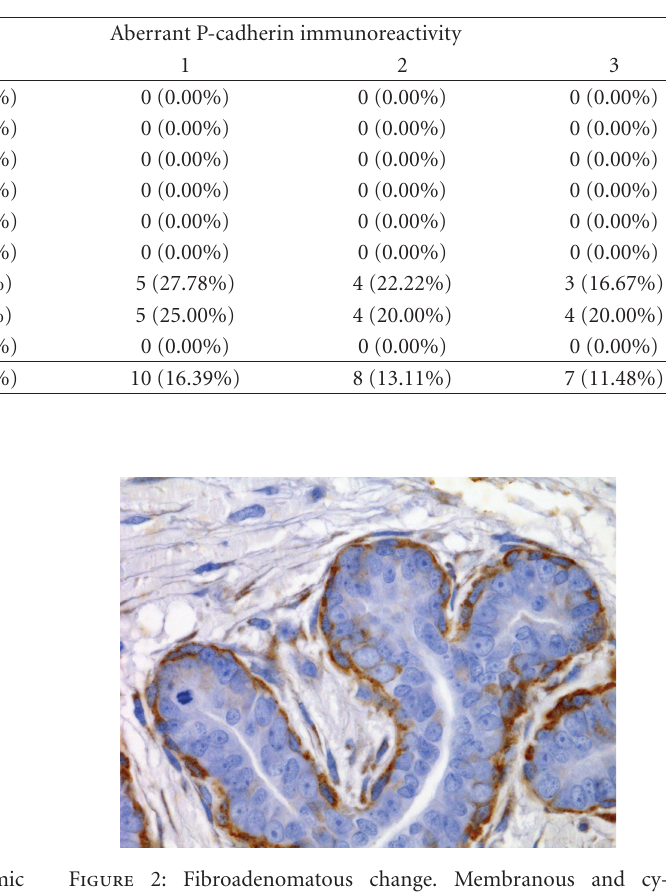
Table 3: Aberrant P-cadherin immunoreactivity in feline mammary tissues.